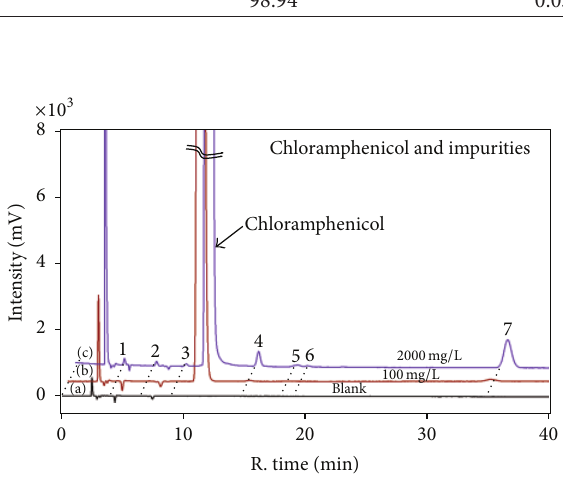
Figure 3: Chromatography of (a) methanol blank, (b) 100mg/L chloramphenicol in methanol, and (c) 2000 mg/L chloramphenicol in